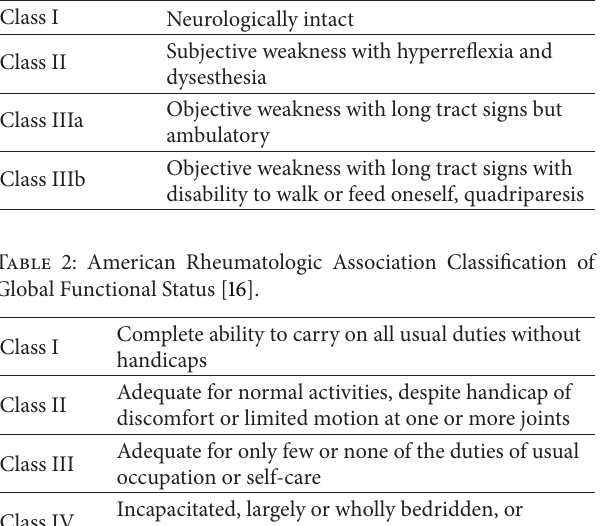
Table 1: Ranawat Classification of Rheumatoid Myelopathy [15].